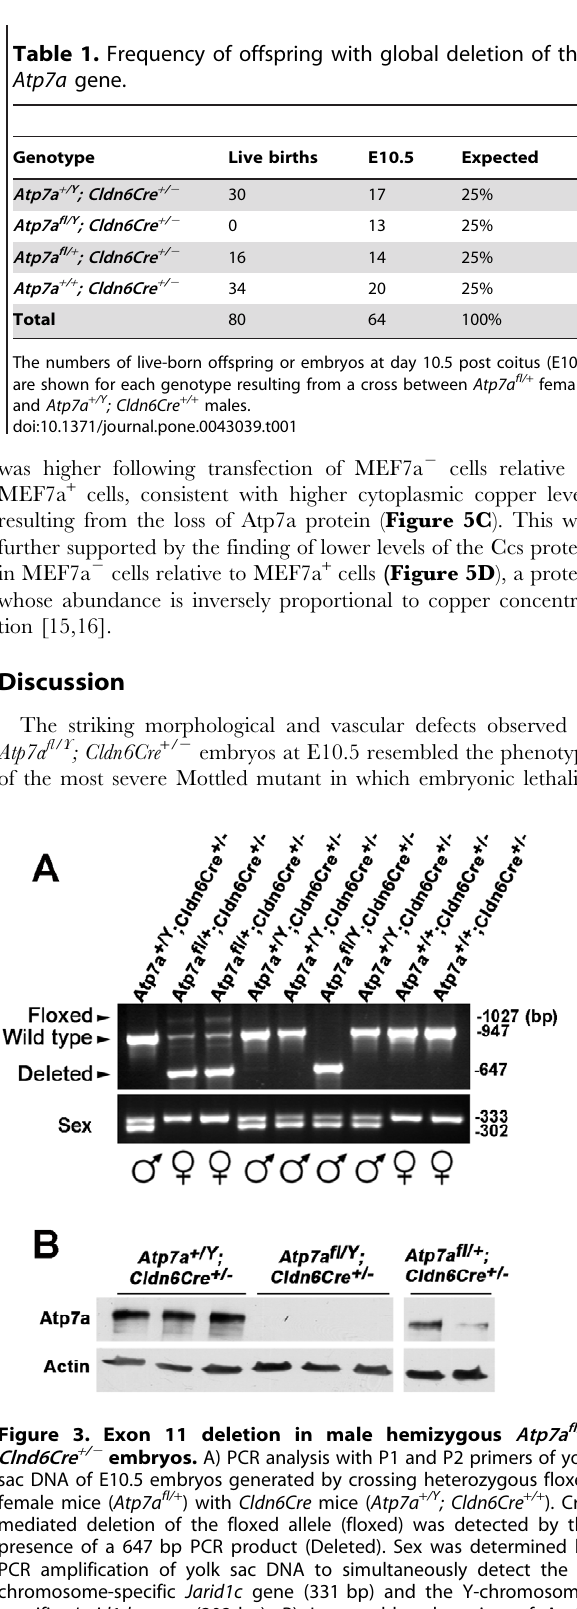
Table 1. Frequency of offspring with global deletion of the Atp7a gene.